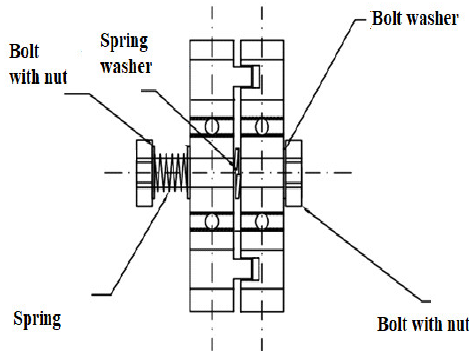
Figure 6. Construction of the elbow joint and wrist of a crash test dummy.